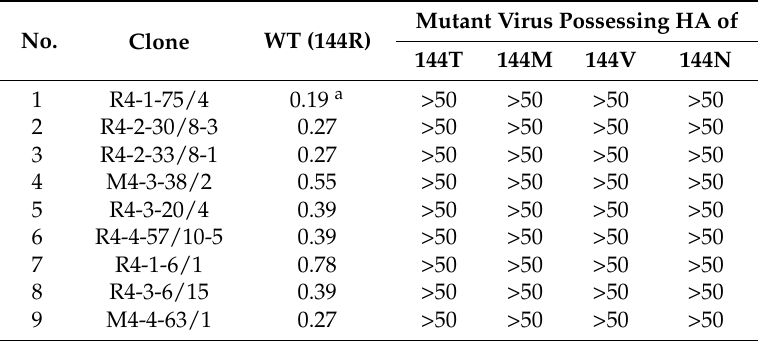
Table 9. Neutralizing activity of the human mAbs against the mutant